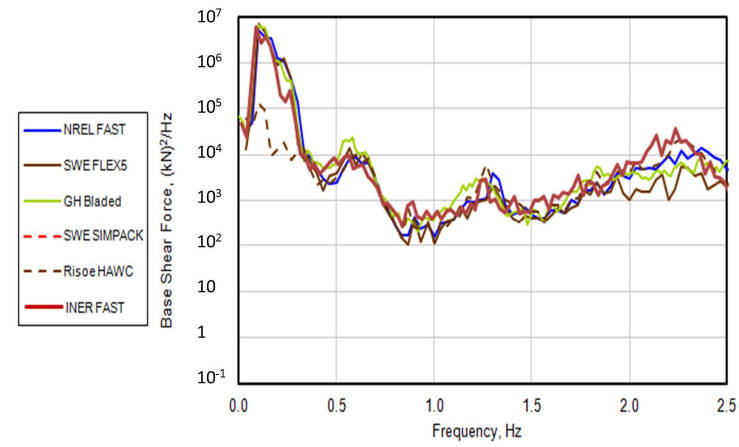
Figure 4. Power Spectra of Base Shear Force under Load Case 5.3 of OC3 Phase I.